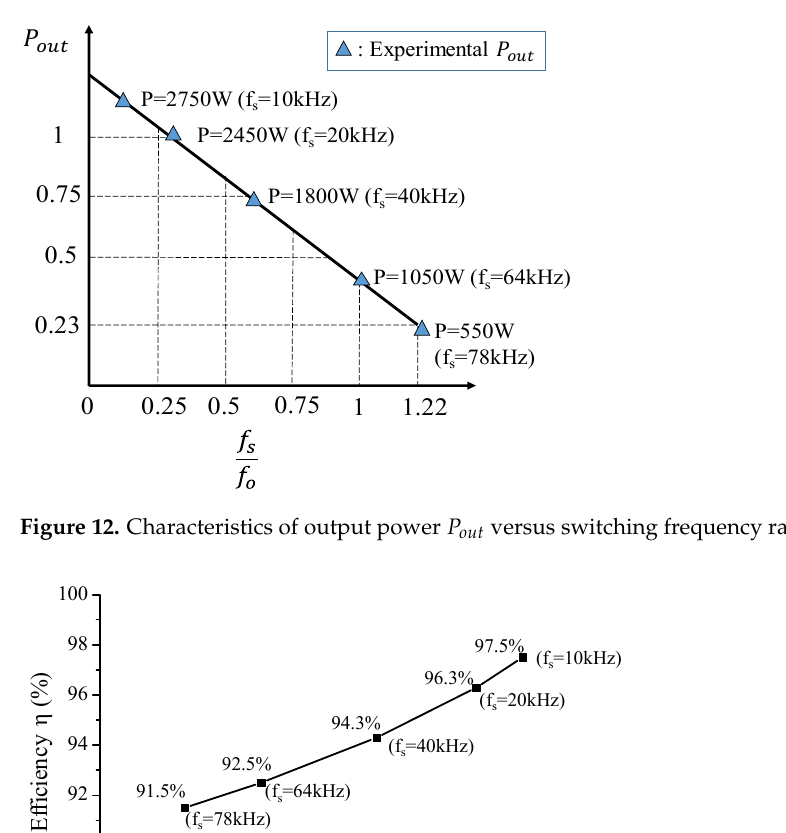
Figure 13. Efficiency versus output power characteristics.